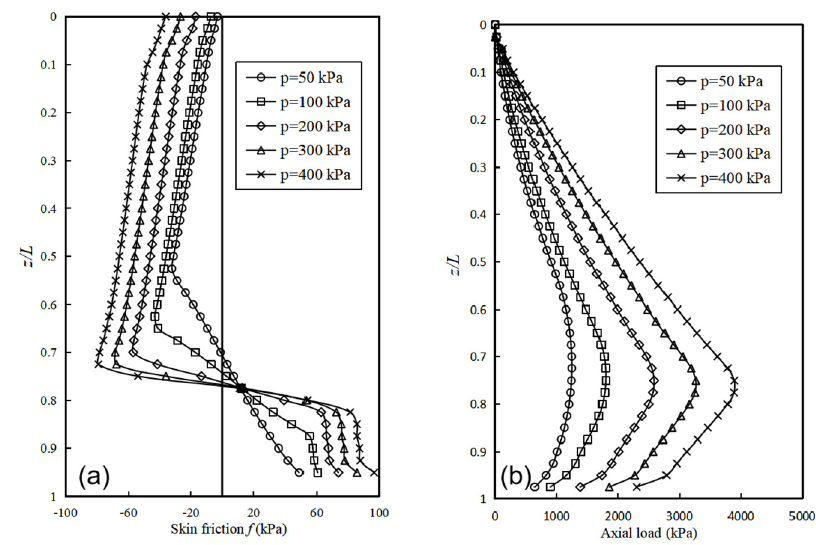
Figure 10. Effect of consolidation pressure on ( a ) skin friction and ( b ) axial load.